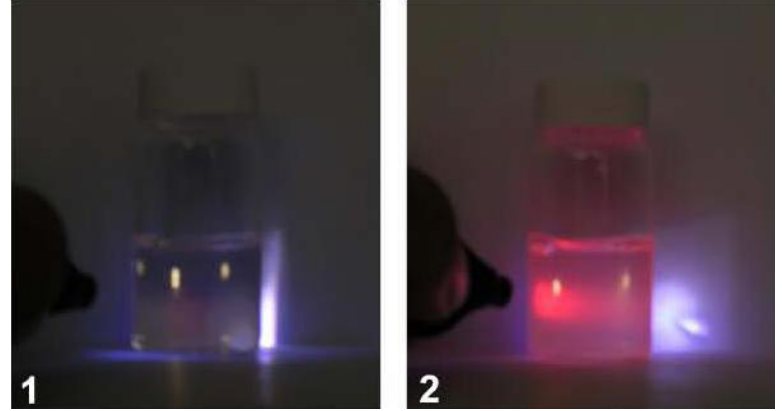
FIGURE 3 . Eu/TTA solution (1.4  10 –3 M ) in seawater (1) without NG and (2) with NG (5  10 –4 M ), illuminated by a handheld UV light (370 nm). The reagent solvent (methanol) comprised 5% of the